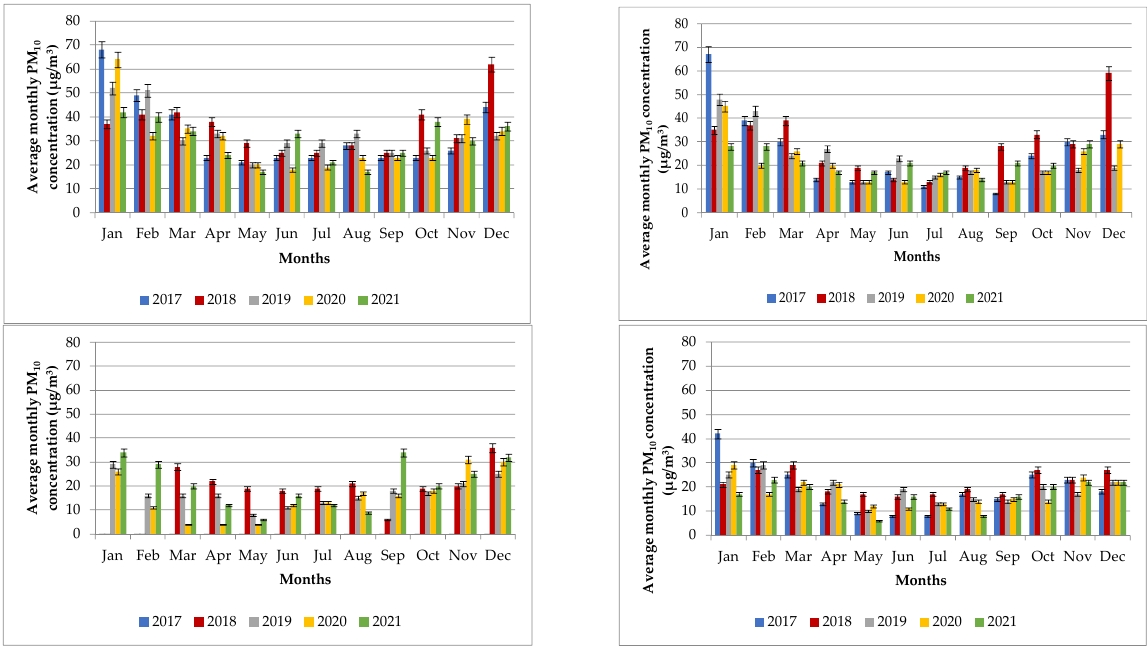
Figure 8. Average monthly PM 10 concentrations at locations A, B, C, and D between 2017 and 2021 (from left to right, from top to bottom).